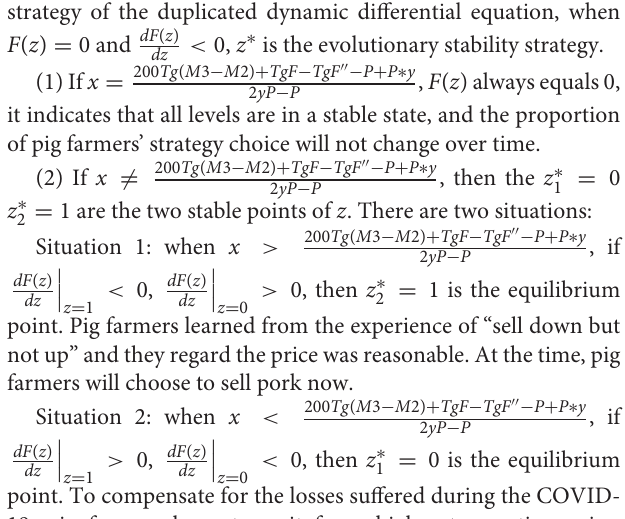
TABLE 3 | Stability analysis of equilibrium solution of a tripartite evolutionary game